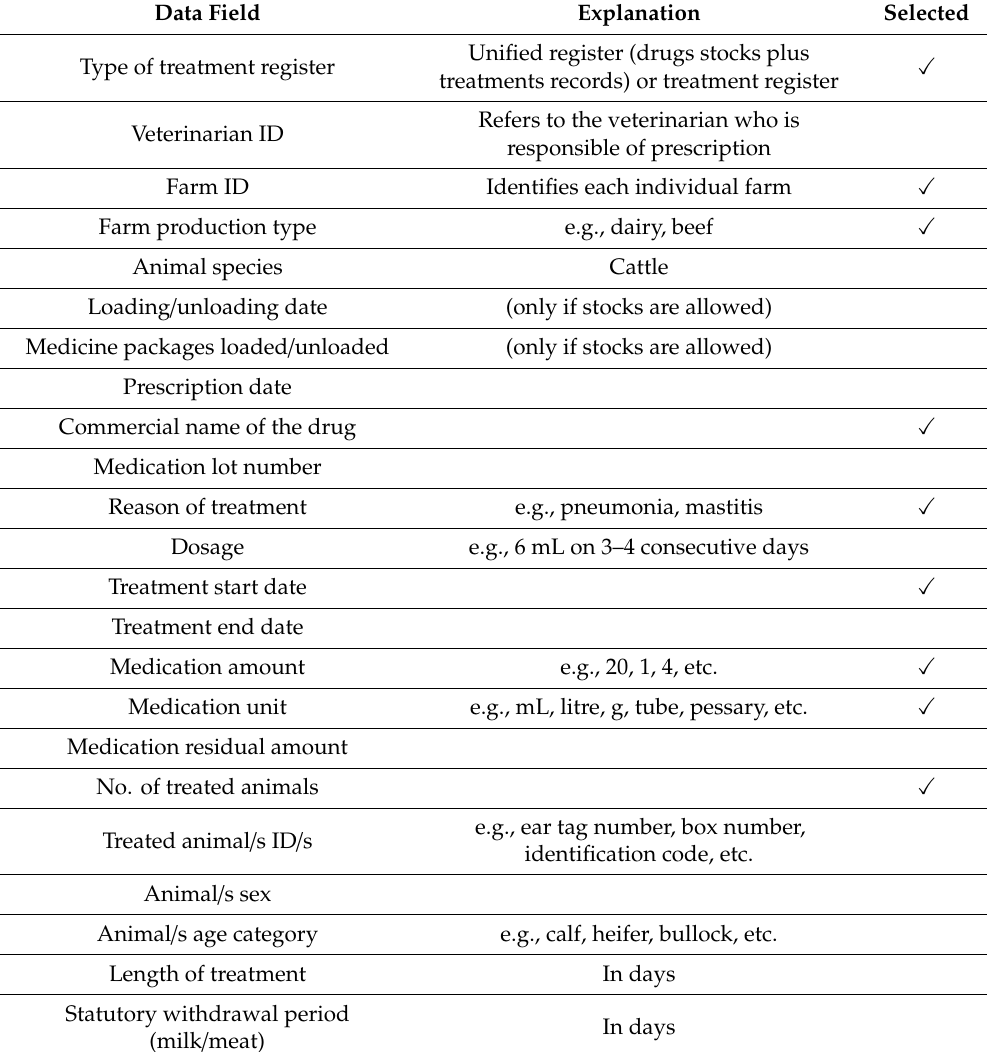
Table 7. Structure of an on-farm paper-based register (with respect to each treatment), and information selected for antimicrobial consumption